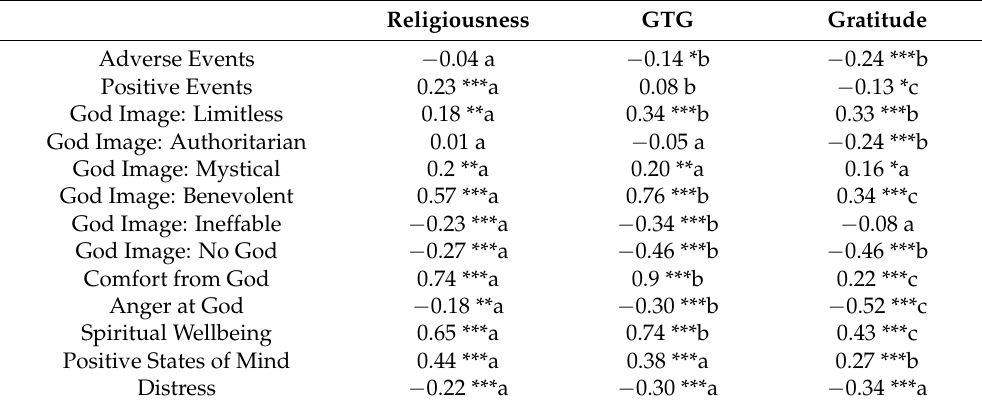
Table 2. Partial Correlations Examining whether GTG Shows Distinctive Patterns of Associations Compared to General Gratitude and General